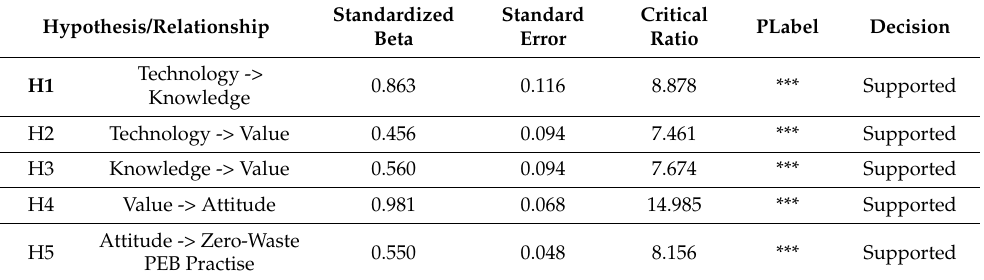
Table 3. Hypothesis Testing (Direct